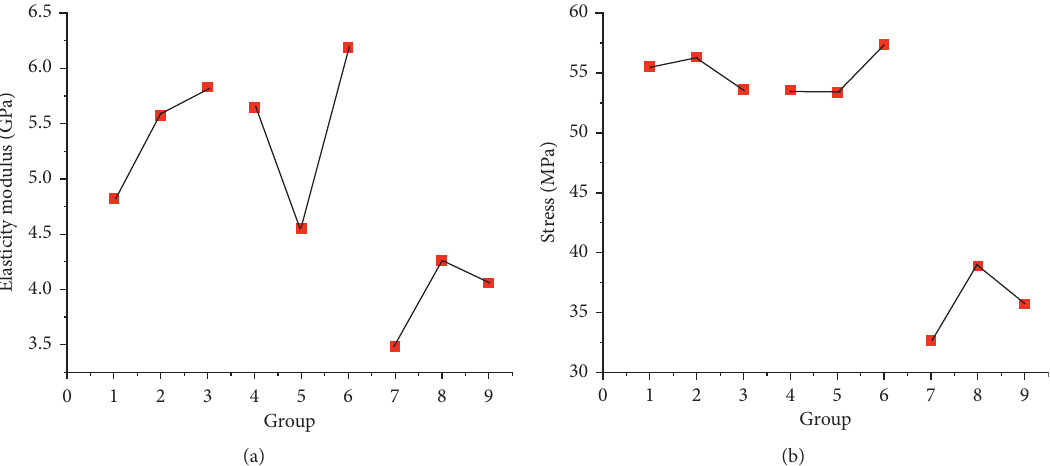
Figure 4: Scatter diagrams of the elastic modulus and maximum stress on rock samples on different moisture conditions. (a) Scatter diagram of elastic modulus. (b) Scatter diagram of the maximum stress.